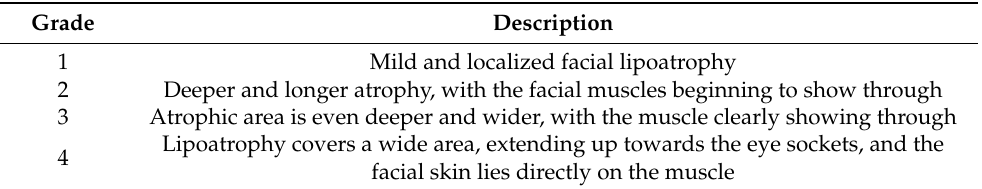
Table 1. James–Carruthers Facial Lipoatrophy Severity Scale. The four grades of HIV-associated facial lipoatrophy are explained in